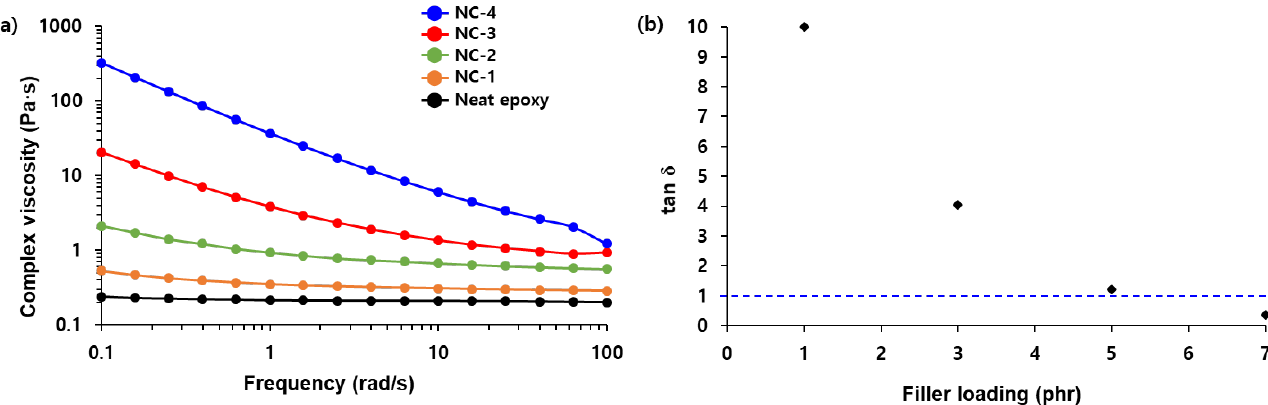
Figure 5. ( a ) Shear-rate dependency of the complex viscosity of neat epoxy and the fumed silica composites and ( b ) the filler loading dependence of tan  measured at 1 rad/s.